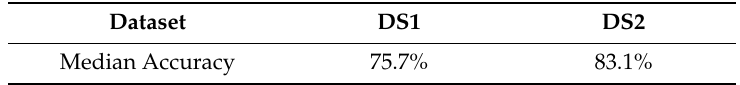
Table 6. Median classification accuracy according to the segmentation technique: data segmented without overlapping (DS1) and data segmented with 50% overlapping (DS2).